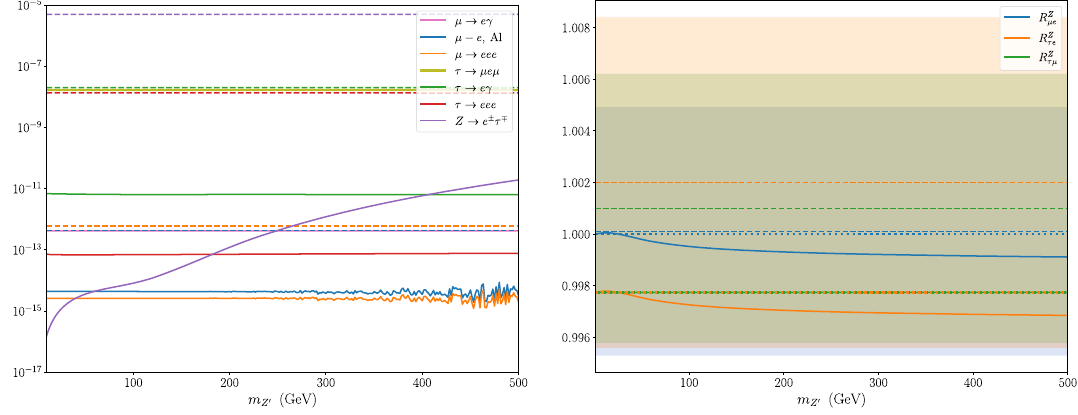
Fig. 10 Illustrative theoretical upper limits for several cLFV decays (left) and predictions for LFU in Z decays (right) for a wide range of Z (cid:2) masses. On the left, full (dahed) lines denote the predicted upper limits (current experimental bounds) for the distinct cLFV observables.